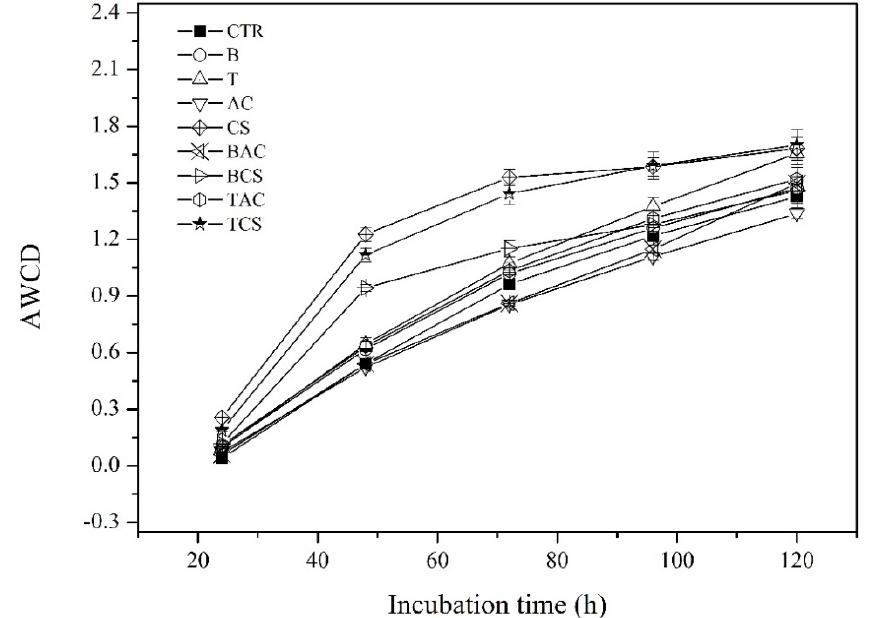
Figure 7. Changes in average well-color development (AWCD) of various amendment treatments with incubation time (CTR: control, B: bentonite, AC: activated carbon, CS: cornstarch). Data are mean ± standard deviation (n = 3).